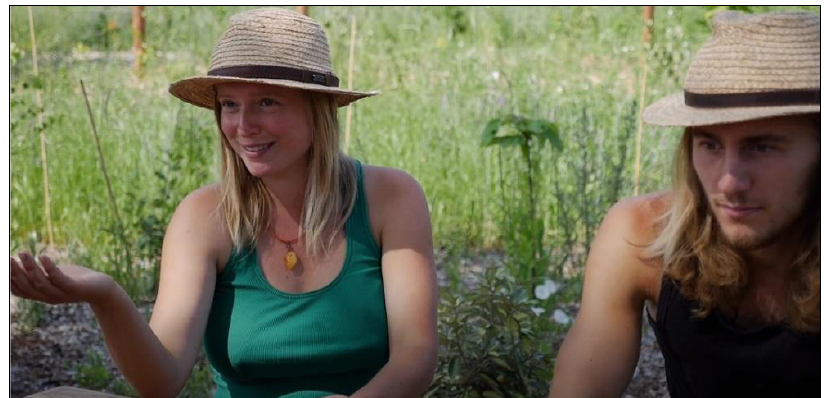
Figure 5. Janine Raabe and Paul Müller, Den Food Bosch, 2018